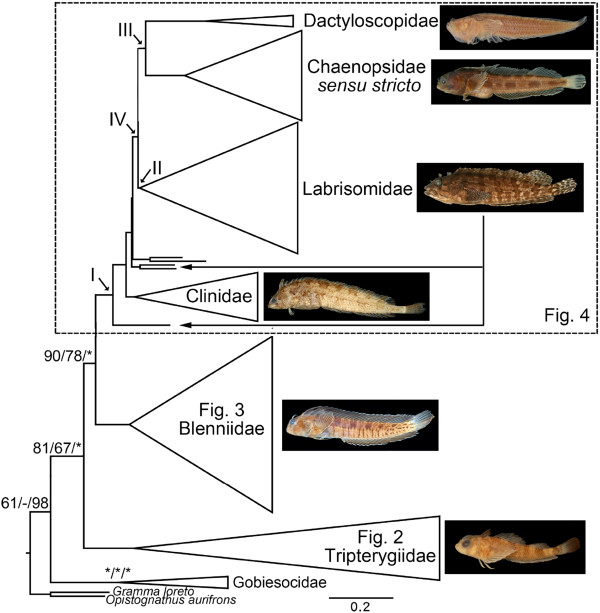
Phylogenetic relationships among major blenniiform clades based on Maximum Likelihood analysis. The supporting values of nodes (Maximum Likelihood bootstrap/Maximum Parsimony bootstrap/Bayesian posterior probability) were only shown if not in Figures 2, 3 and 4 where the phylogenetic relationships are shown in detail. *=100. - = not supported. Representative photos of the six blenniiform families are Enneanectes macrops (Tripterygiidae), Hypsoblennius striatus (Blenniidae), Myxodes ornatus (Clinidae), Labrisomus xanti (Labrisomidae), Acanthemblemaria hastingsi (Chaenopsidae), and Dactyloscopus lunaticus (Dactyloscopidae).